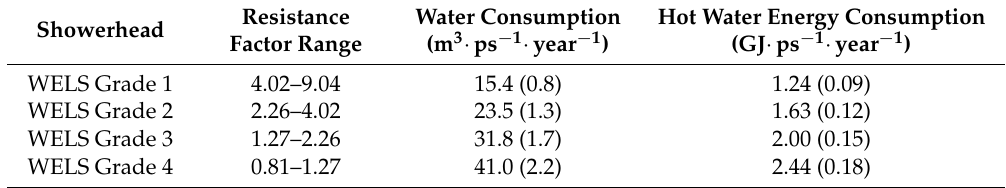
Table 6. Predicted water and energy consumption results for WELS rated showerheads.